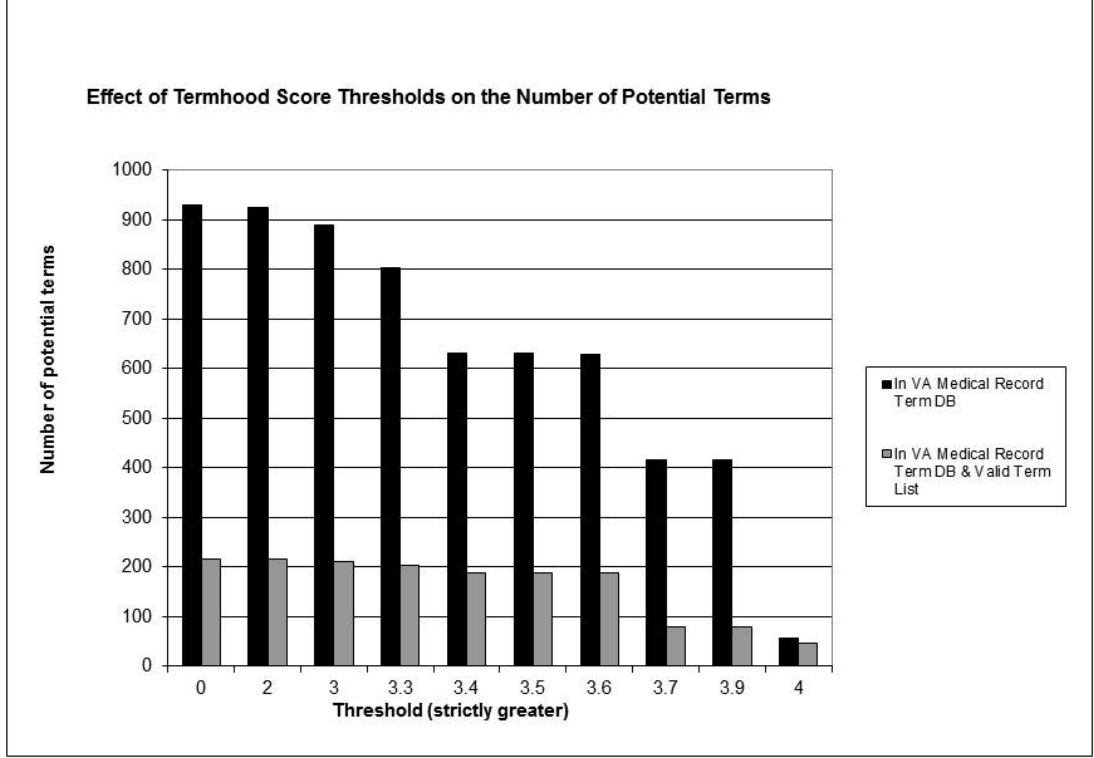
Figure 2. Effect of termhood score thresholds on the number of candidate